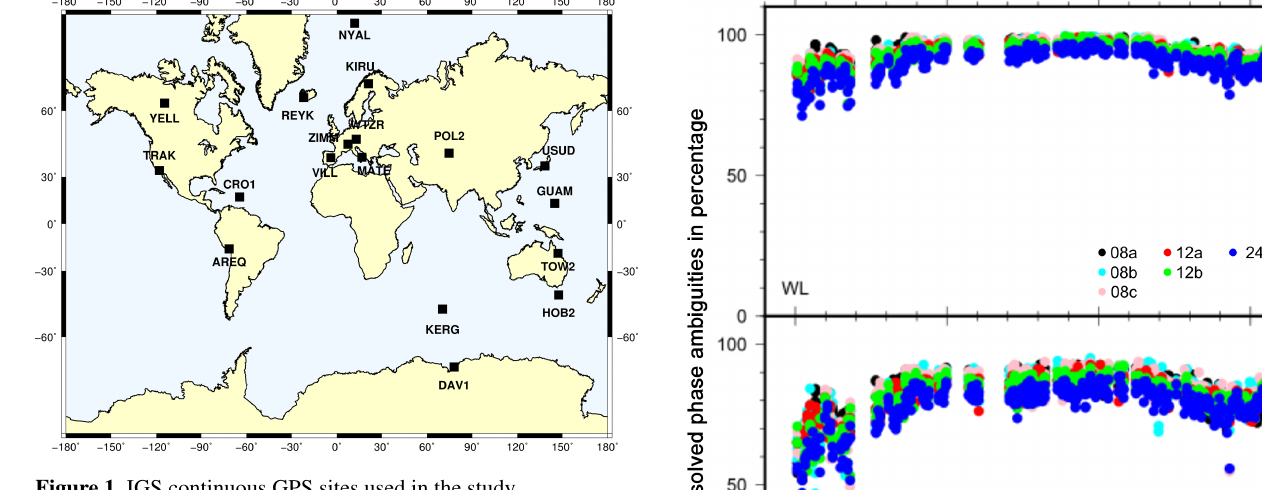
Figure 1. IGS continuous GPS sites used in the study.